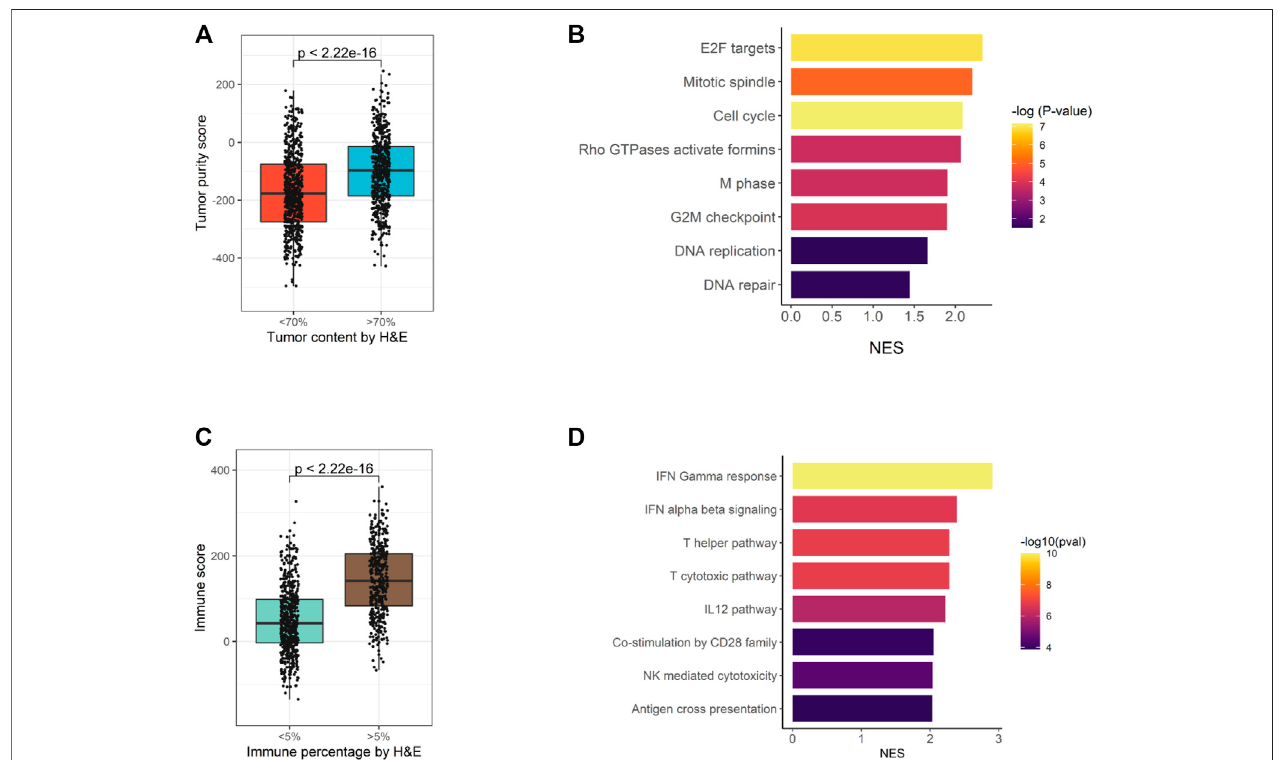
FIGURE 4 | Consistency of EdgeSeq PIP data with H&E staining. (A) Boxplot showing the difference in tumor purity scores between samples with high ( > 70%) tumor percentage and low ( < 70%) tumor percentage. (B) Barplot showing the top eight pathways enriched in tumors with high ( > 70%) tumor percentage. (C) Boxplot showing the difference in immune scores between samples with high ( > 5%) immune percentage and low ( < 5%) immune percentage. (D) Barplot showing the top eight pathways enriched in tumors with high ( > 5%) immune percentage.